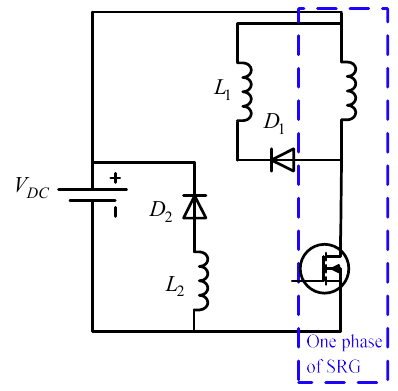
Figure 9. Derishzadeh converter topology.